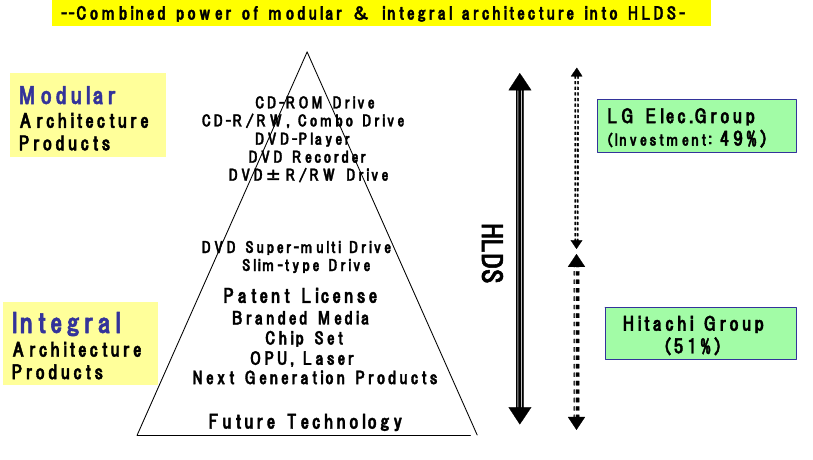
Figure 8. Hitachi-LG: Global Vertical Integration